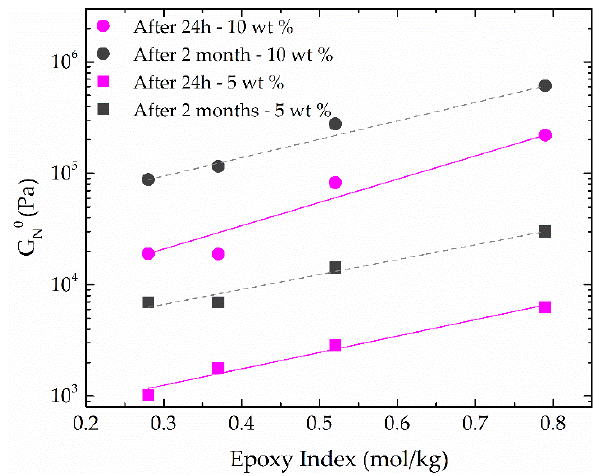
Figure 6. Evolution of G N0 with lignin epoxy index for EAL-based oleogels (5 and 10 wt % EAL) 24 h and 2 months after preparation.